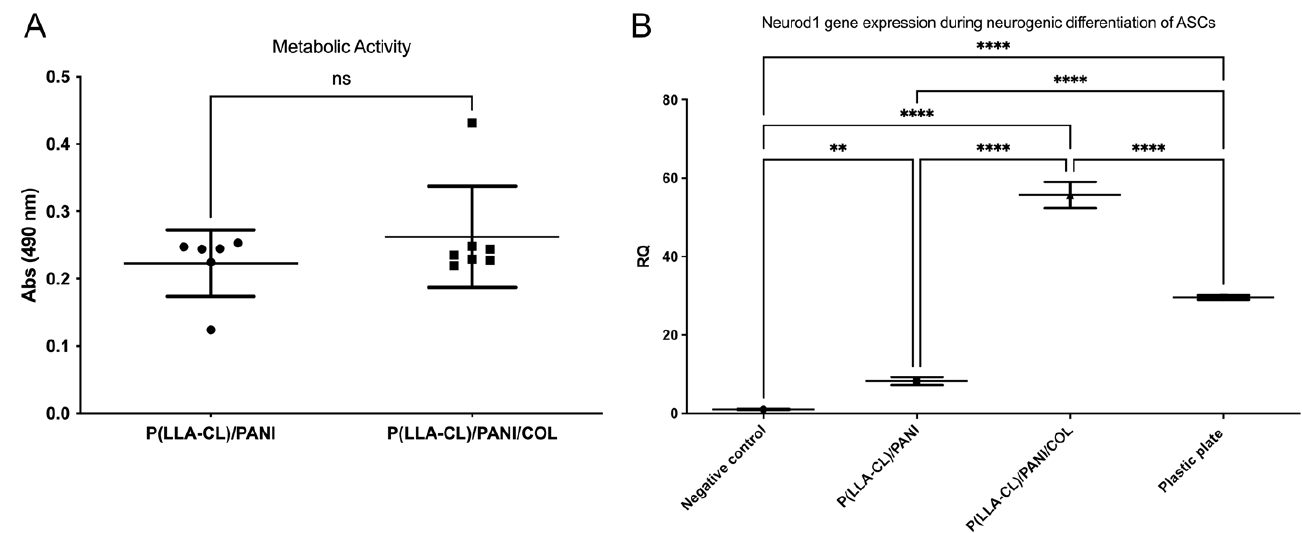
Figure 2. ( A ) Metabolic activity of ASCs cultured on P(LLA-CL)-PANI and P(LLA-CL)-COL-PANI electrospun fibrous meshes; ( B ) Neurod 1 gene expression during the neurogenic differentiation of ASCs on P(LLA-CL)-PANI, P(LLA-CL)-COL-PANI and plastic plate (positive control). Negative control—ASCs cultured on plastic without differentiation medium; Significant difference: ** p < 0.01; **** p < 0.0001.